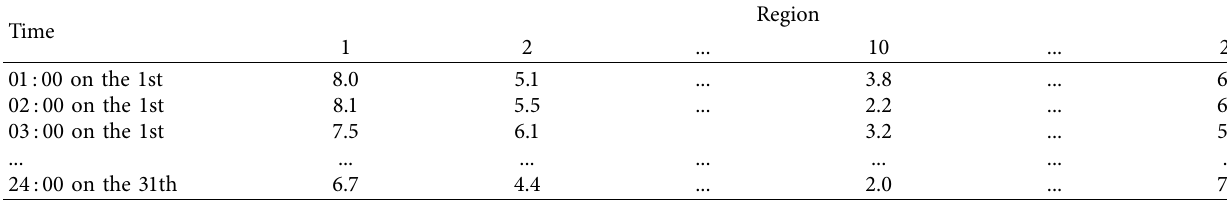
Table 1: Wind speed value at monitoring point (m/s).